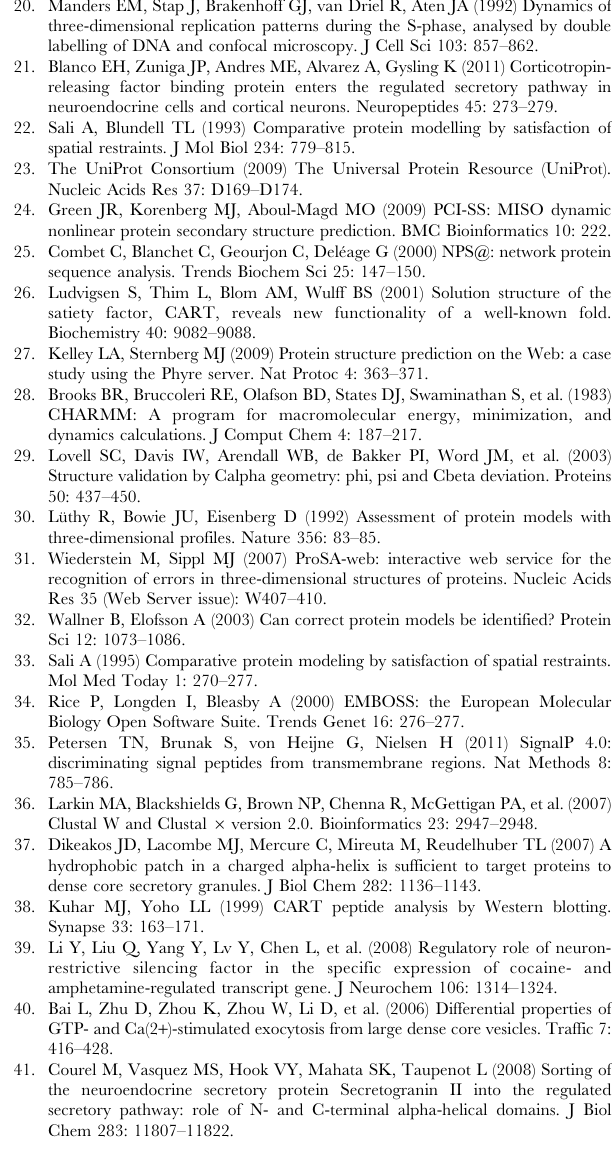
Table S2 Nucleotidic analysis of pre-proCART gene intron-1. Posible explanation for the absence of a human long proCART isoform. The pre-proCART gene sequences corresponding to the coding region of exon-1, intron-1 and exon-2 for the three species were aligned and analyzed. The 5 9 -end of intron-1 is highlighted in black. The 3 9 -ends of the intron yielding the longer proCART isoform documented in rodents are highlighted in gray (proximal 3 9 -end). The 3 9 -ends of the intron yielding the shorter isoform documented in both rodents and humans are highlighted in dark gray (distal 3 9 -end). Both 3 9 -end splicing sites are very similar and have weak polypyrimidine tracks, yielding similar probability to be a 3 9 -end splicing site (Lopez,